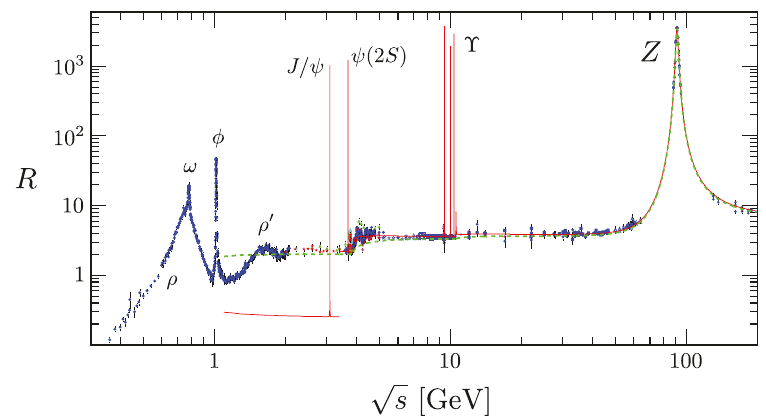
(cid:22) + (cid:22) (cid:0) ) as a function of the center-of-mass !